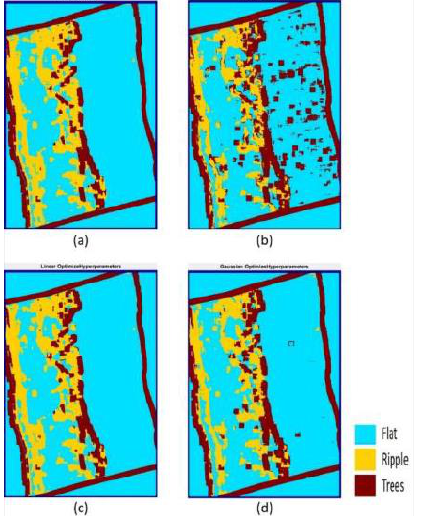
Figure 6. Using feature combination 6, the results of the SVM classification using: (a) linear kernel, (b) Gaussian kernel, (c) linear optimised Hyperparameter, and (d) Gaussian optimised Hyperparameter.